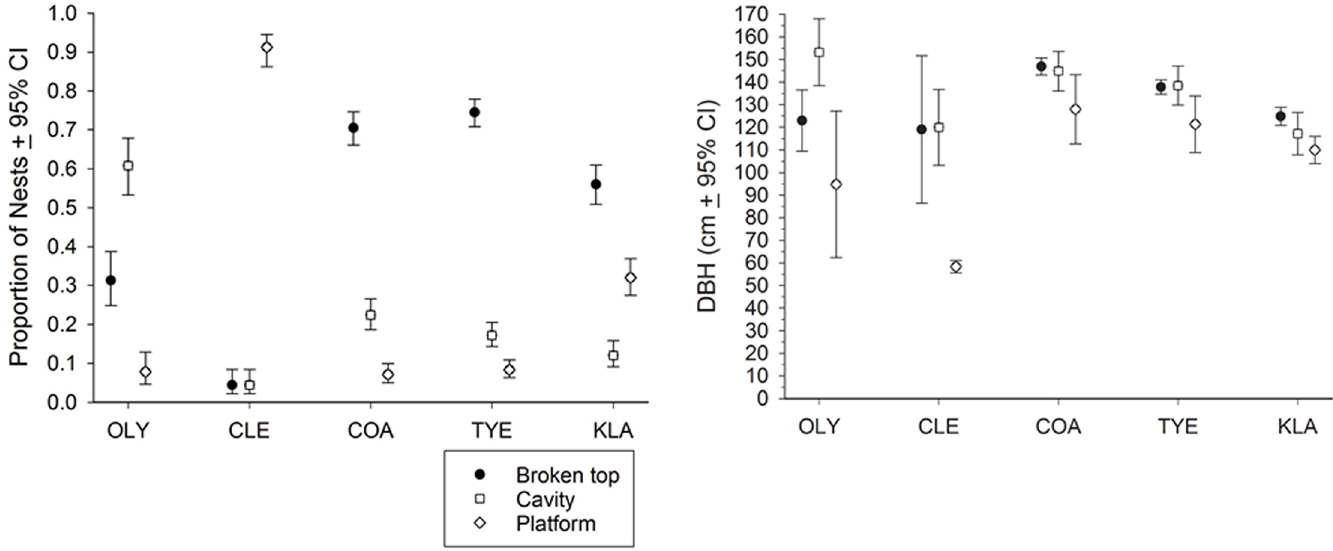
Fig 3. Proportion (L) and diameter at breast height (R) of nest trees of northern spotted owls in Washington and Oregon, United States, subdivided by study area and nest type.